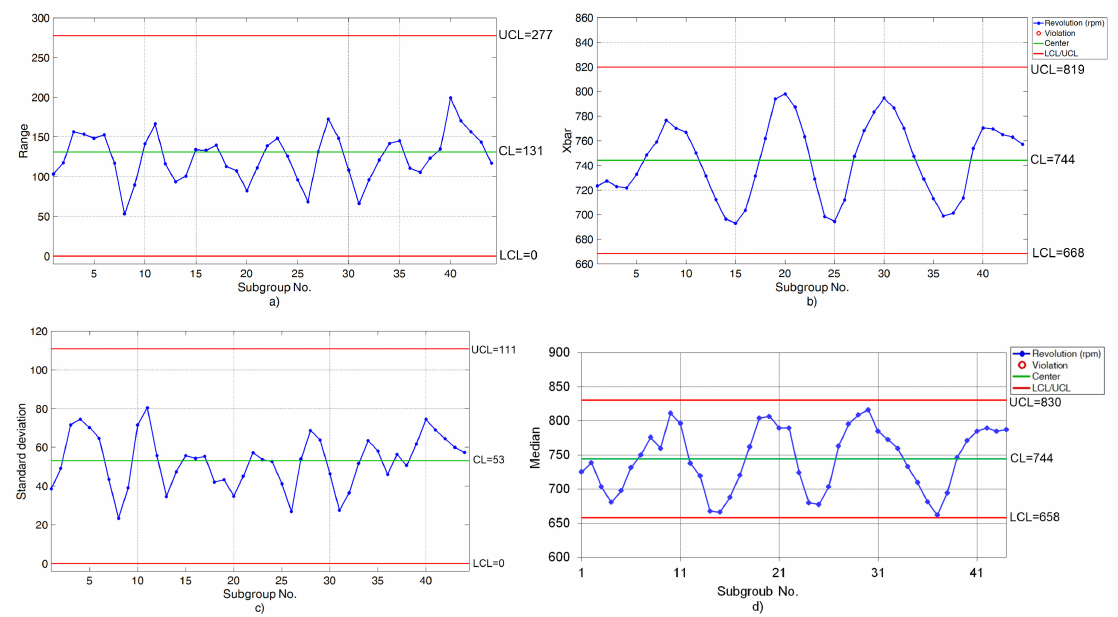
Figure 10. Control charts for the technological parameter of revolutions: ( a ) diagram of variation range, ( b ) diagram of arithmetic mean, ( c ) diagram of standard deviation, ( d ) diagram of the median. Table 9. Values of the center line and control limits for the